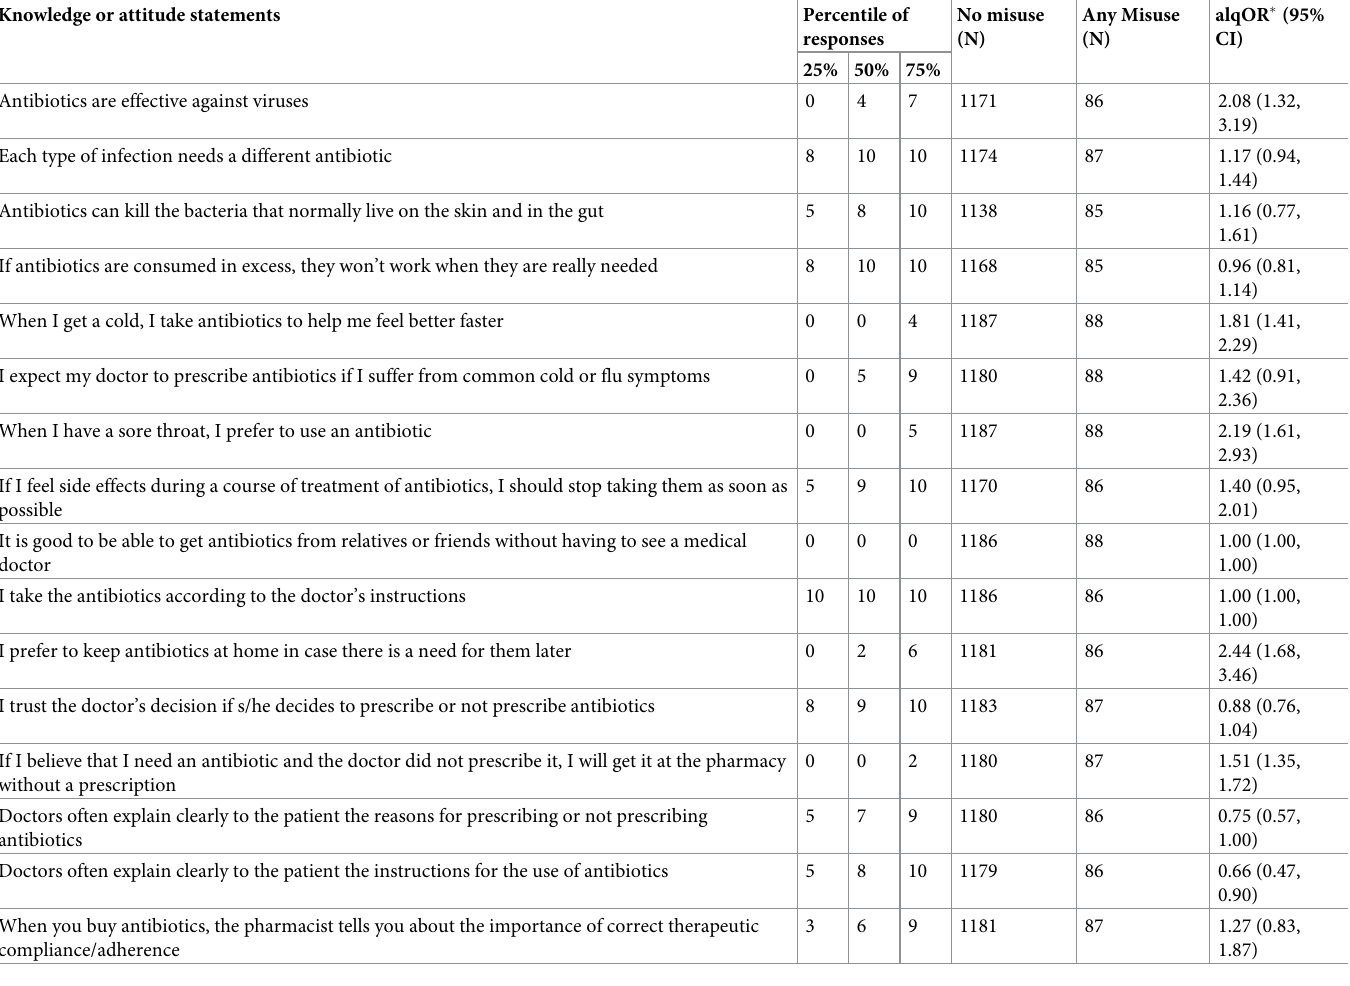
Table 2. Association of knowledge and attitudes with any misuse of antibiotics in 1392 parents of